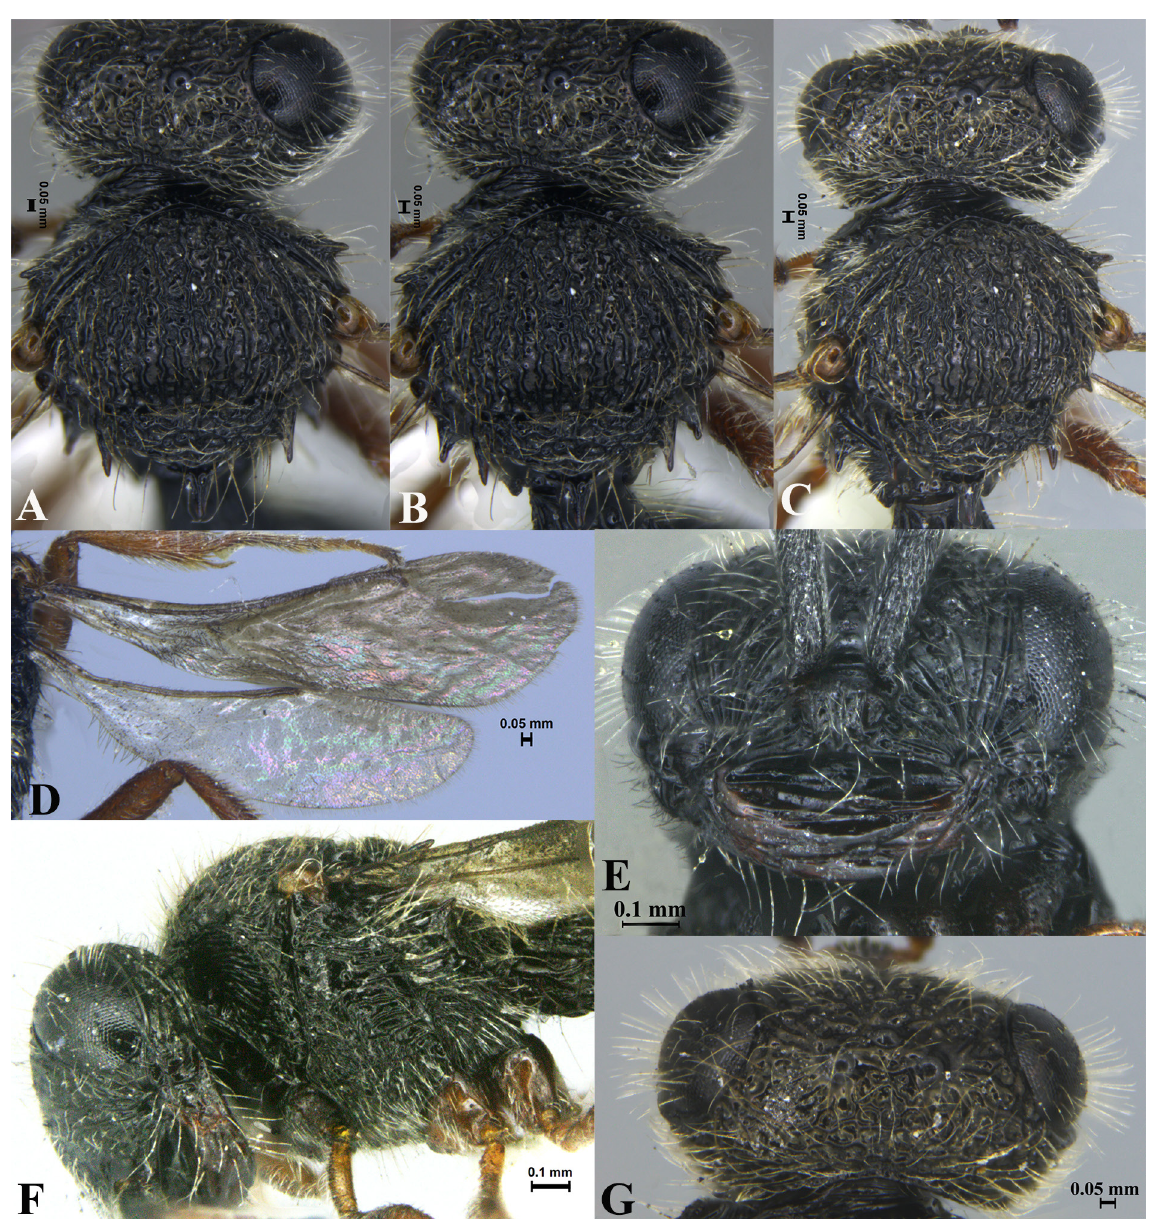
Fig. 4. Odontoscelio spinosus sp. nov. Holotype, ♀ (ICAR-NBAIR P3960). A – C . Mesoscutum showing axillular spines at different angles. D . Wings. E . Facial striae. F . Head and pleuron. G .